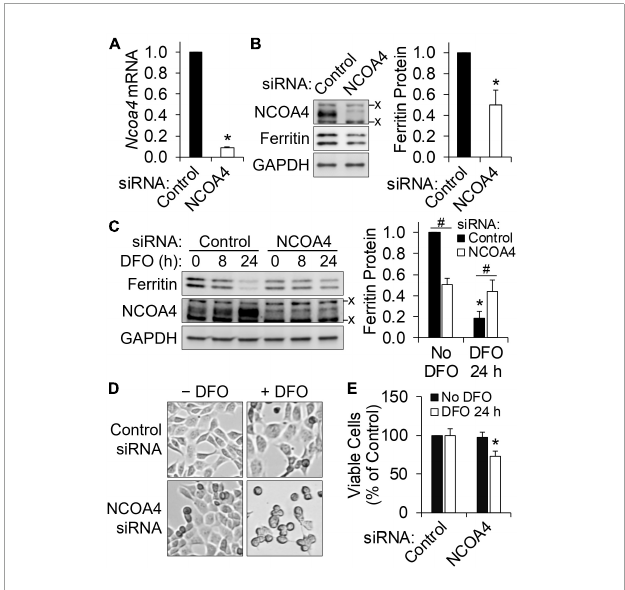
FIGURE2 HT22 neuronal cells require NCOA4 for ferritin turnover and survival during iron restriction. NCOA4 was knocked-down via liposome-mediated siRNA delivery, and DFO (100 µ M) was added to induce iron deficiency. (A) siRNA-induced Ncoa4 knockdown confirmed by qPCR, normalized to Tbp levels. (B) Loss in ferritin protein by NCOA4 depletion. Ferritin quantitation was normalized to GAPDH. (C) NCOA4 deficiency impairs the repression of ferritin by iron restriction. * P < 0.05 by DFO; # P < 0.05 by NCOA4 depletion. (D,E) Morphological changes (D) and reduced viability (E) of NCOA4-depleted HT22 neuronal cells by iron restriction. Data presented as mean ± SD of n = 3–6 independent experiments. * P < 0.05 compared with control levels. x, non-specific band. siRNA, small interfering RNA; qPCR, quantitative real-time